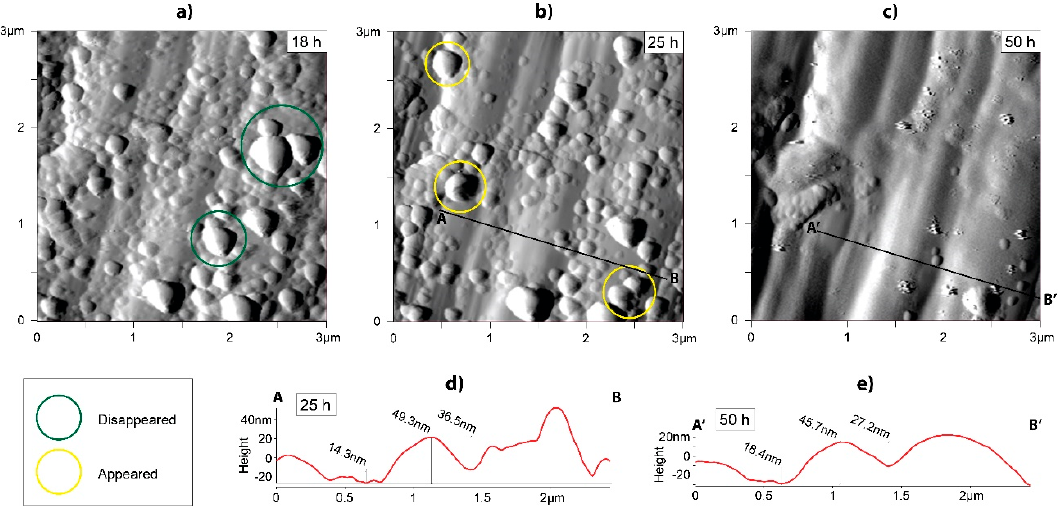
Figure 4. Sequence of amplitude retrace AFM images of the same area of FF in ALF solution at 25 °C (pH 4.15), at different time of interaction: ( a ) 18 h; ( b ) 25 h; ( c ) 50 h. The particles movement and removal (yellow and green circle in ( a ) and ( b )) and the surface dissolution in sections ( d ) and ( e ) is appreciable.